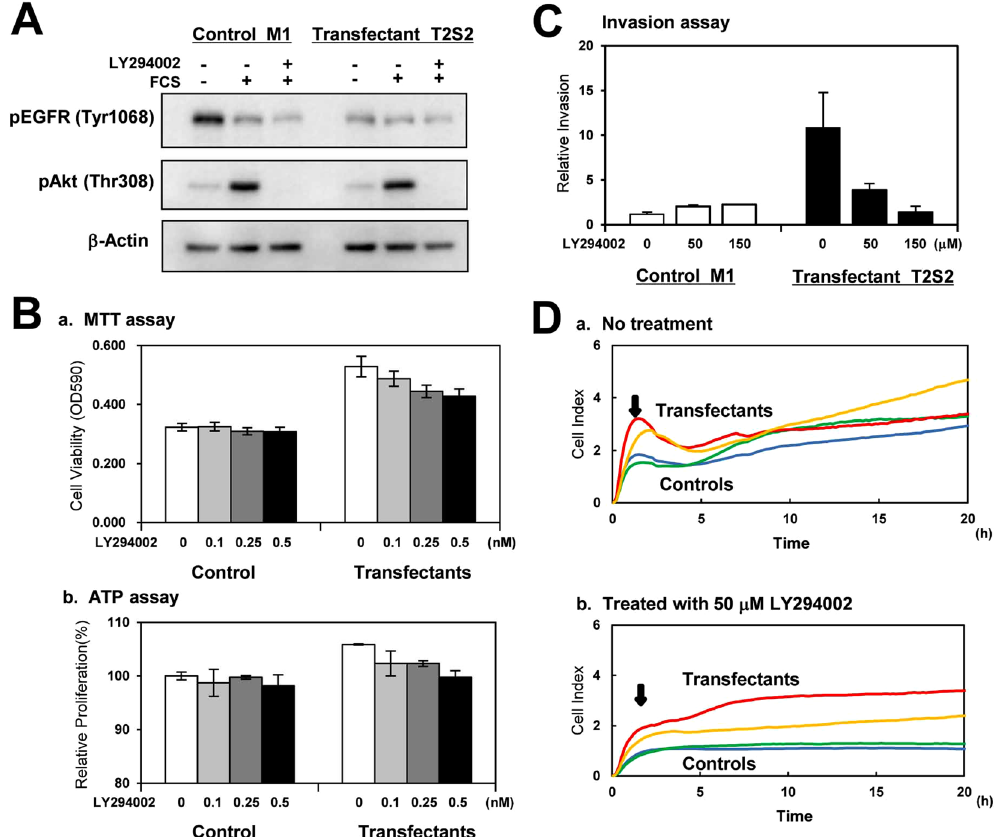
Figure 6. A PI3K inhibitor suppressed Akt phosphorylation and malignant properties of the transfectant cells. ( A ) Cells were cultured in serum free-medium overnight, and then treated with 50 μ M LY294002 for 30 min. After treatment with serum-containing D-MEM for 5 min, cell lysates were prepared as described in “Materials and Methods”. Cropped blots were used here and uncropped imagesof blots are shown in Supplemental Figure S7 respectively. ( B ) To compare cell proliferation, MTT assay and ATP assay were performed. For MTT assay, transfectant cells and control cells (5.0 × 10 3 cells/well) were prepared in 48-well plates in serum- containing D-MEM and cultured for 5 days ( a ). For ATP assay, transfectant cells and control cells (7.5 × 10 2 cells/well) were prepared in 96-well plates in serum-containing D-MEM and cultured for 4 days ( b ). Bars indicate mean ± S.D. (n = 3). ( C ) For invasion assay, transfectant cells and control cells (2.5 × 10 4 cells/well) were cultured in serum-containing D-MEM for 16 h. Bars indicate mean ± S.D. (n = 3). ( D ) For adhesion assay to laminin, the transfectant cells and control cells (1.0 × 10 4 cells) were treated with 50 μ M LY294002 for 22 h and seeded in the wells of e-plates. Red and yellow lines mean transfectant cells, and green and blue lines mean control